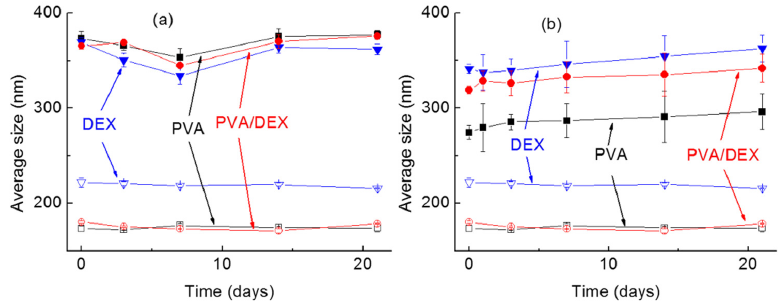
Figure 3. Average dimensions of the NPs over time (up to 21 days). In the graph, the hollow symbols correspond to the empty NPs while the full ones to the NPs loaded with ( a ) DOXO and ( b ) SN-38. ■ : PVA; ▼ : DEX; ● : PVA/DEX.